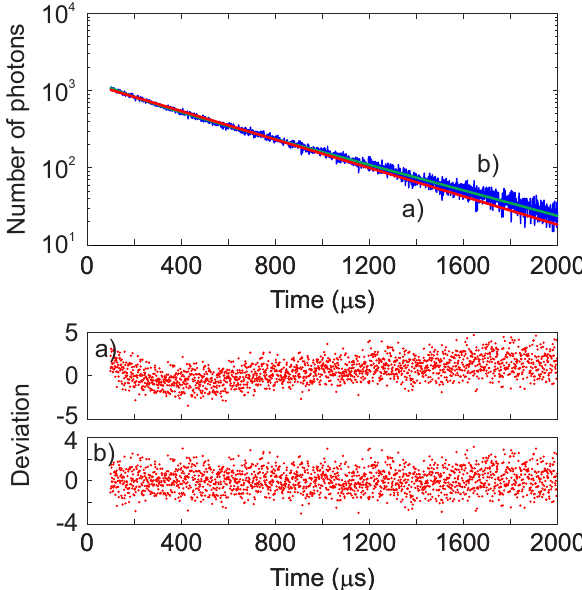
Figure 5. Upper panel: Time-domain intensity decay time at 20 ◦ C for the sample with 0.20% doping. The red solid line ( a ) shows the monoexponential function fit with χ 2 ( b ) shows the double exponential function fit with χ 2 mono- ( a ) and double ( b ) exponential